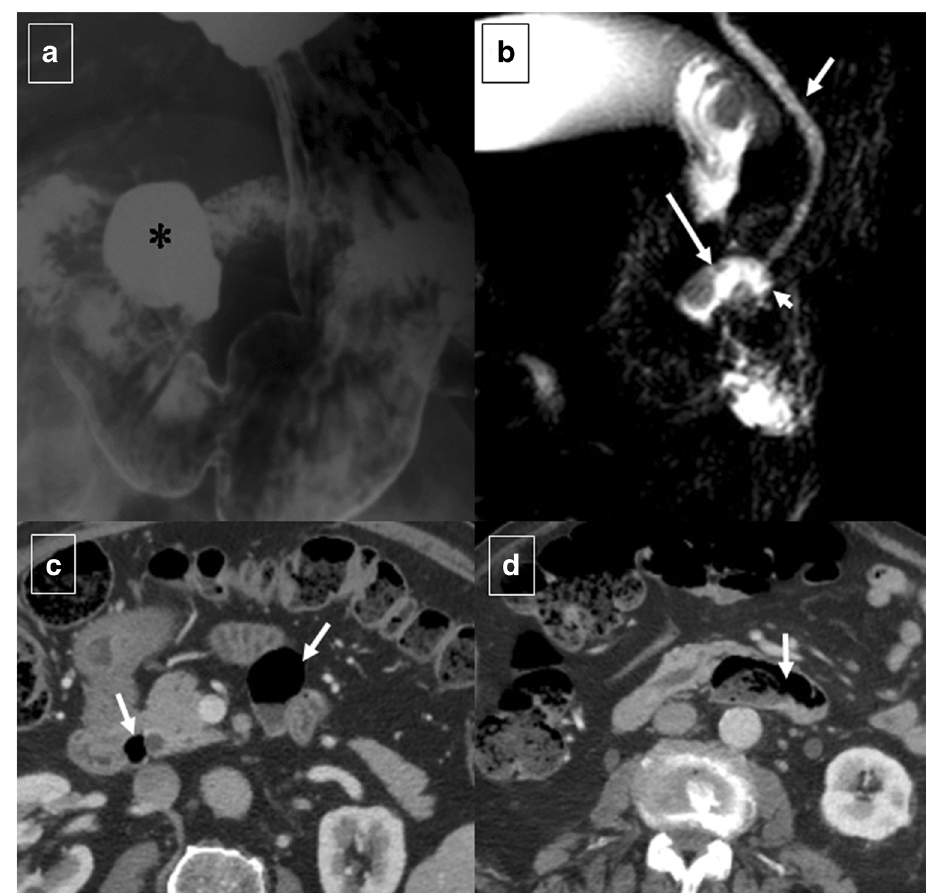
Fig. 3 Duodenal diverticula in different patients. a Anteroposterior image from a single-contrast upper gastrointestinal series shows a typical outpouching (*) arising from descending duodenum. b Magnetic resonance cholangiopancreatography shows a heterogeneous outpouching (large arrow) in the papillary region. Note common bile duct (arrow) and proximal Wirsung duct (arrowhead). c Axial CT demonstrates two duodenal diverticula (arrows) in the